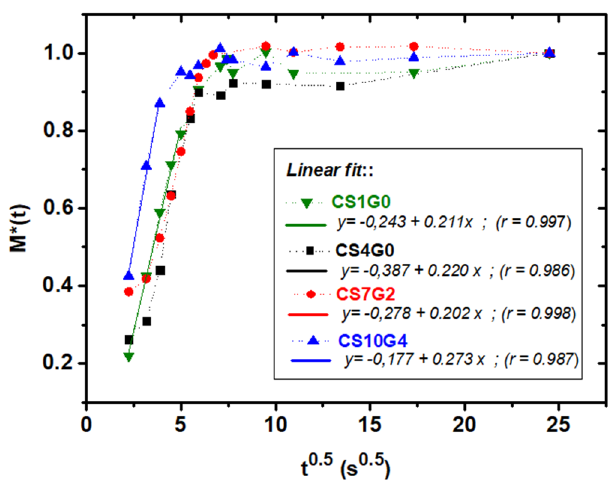
Figure 6. Normalized absorbed mass ratio for CS1G0, CS4G0, CS7G2 and GS10G4 aerogels during liquid PBS absorption versus square-root time. Lines correspond to linear fittings according to standard model of mass increase by imbibition due to capillary rise.